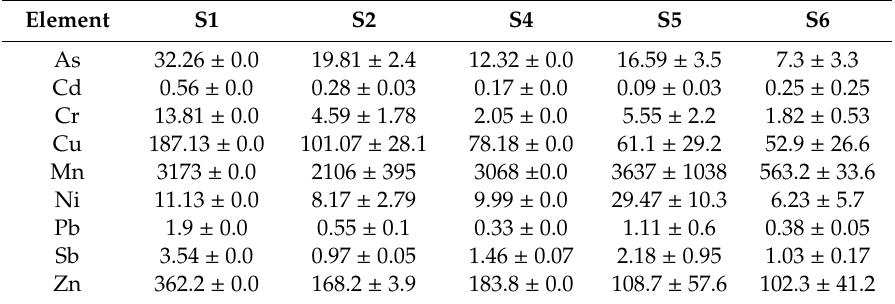
Table 4. Concentration of chemical elements (Mean ± S.E) in the tissue of Gomphidae (Odonata) larvae at di ff erent sites of the Blyde River (S.E: standard